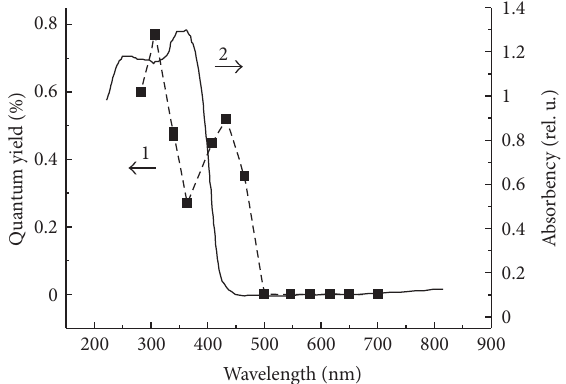
F 5: Spectral dependencies for the titanium dioxide sample produced from a monocrystal: (1) the quantum yield of CO photodesorption in the presence of Freon 134a and (2) the optical density relative to MgO.